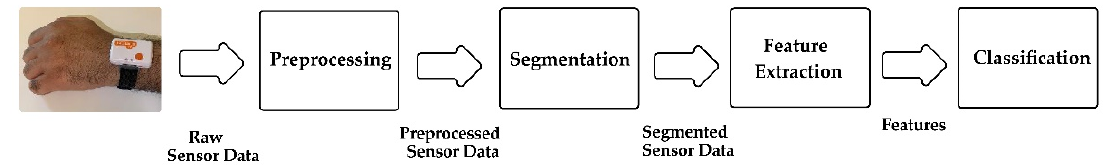
Figure 2. Physical activity recognition pipeline.